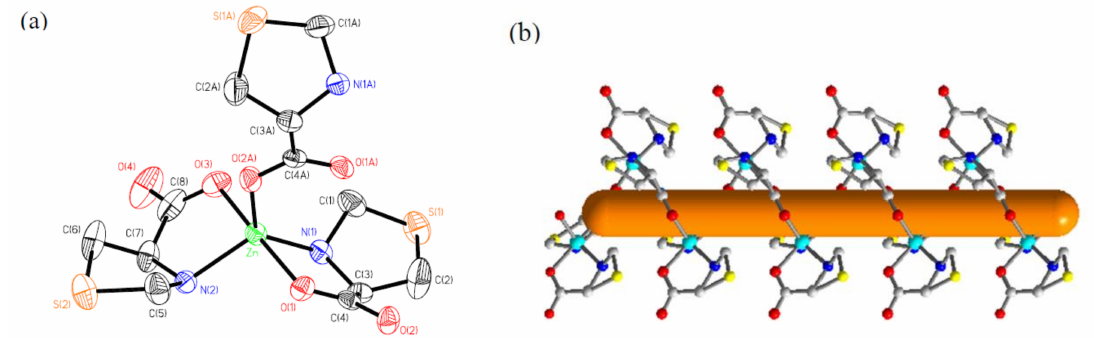
Figure 3. Structures of compound 2 : ( a ) the coordination environment of the Zn(II) ion; ( b ) a simplified right-handed single-stranded helical